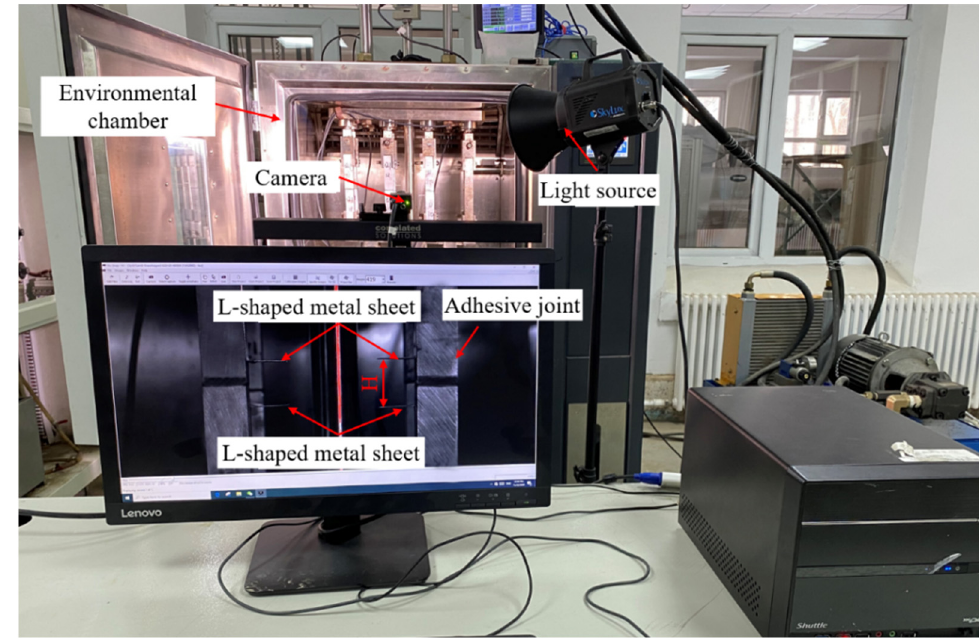
Figure 3. Creep test.